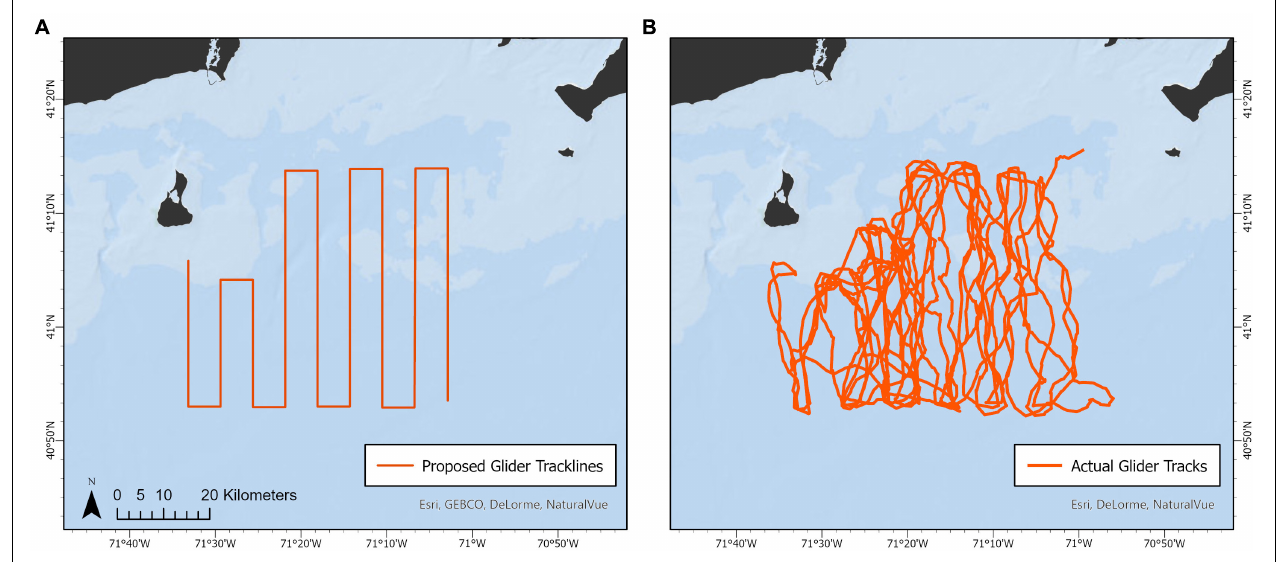
FIGURE 5 | Example of (A) proposed glider tracklines compared to (B) actual tracklines traveled from a real-time slocum glider deployment off Cox’s Ledge in 2019. This design was used both for detecting spawning Atlantic cod as well as North Atlantic right whales and other baleen whale species.